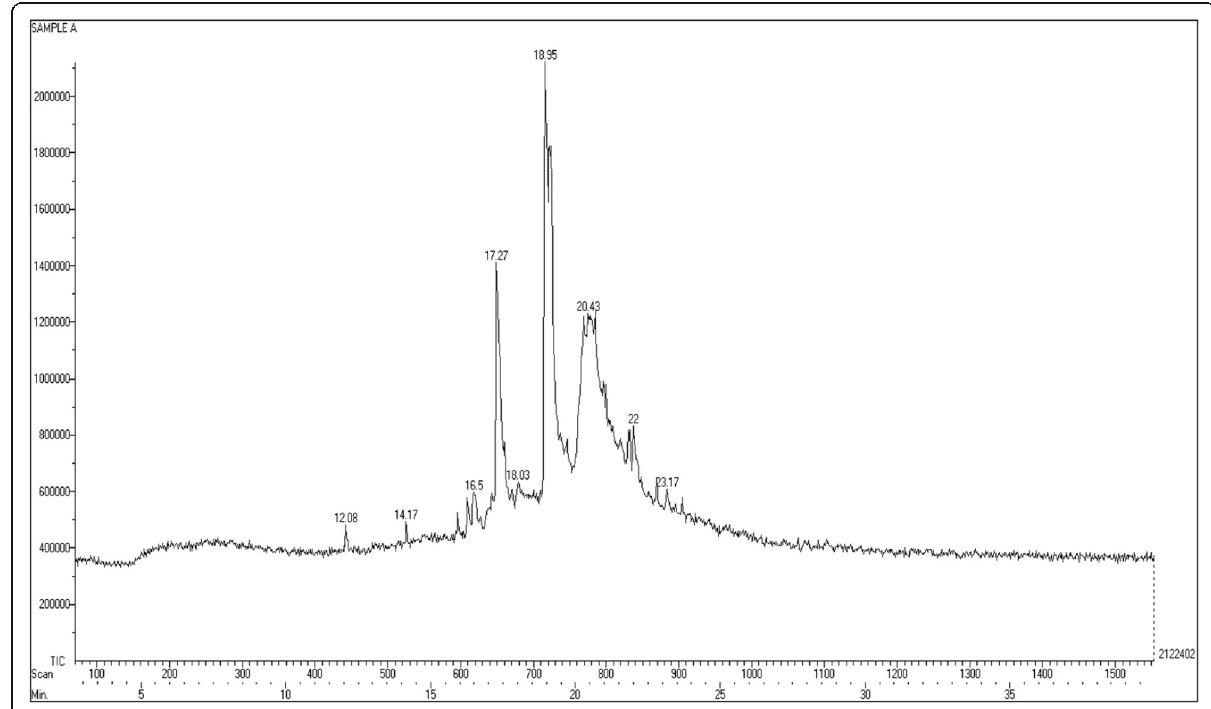
Fig. 9 Gas chromatogram with mass-spectrometric detection of the methanolic extract of an in vitro grown L. cruciata